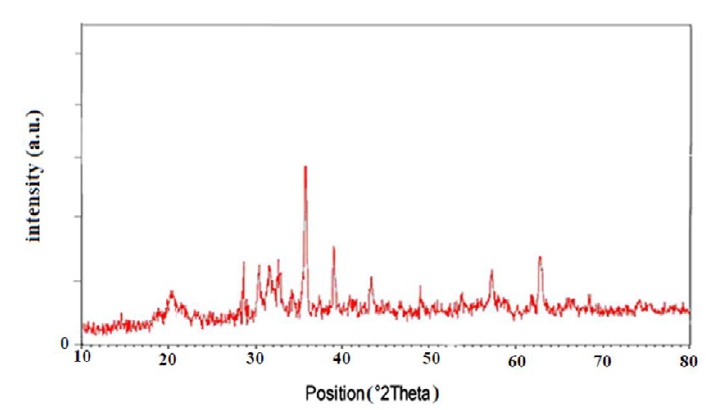
Fig 2. The XRD of H